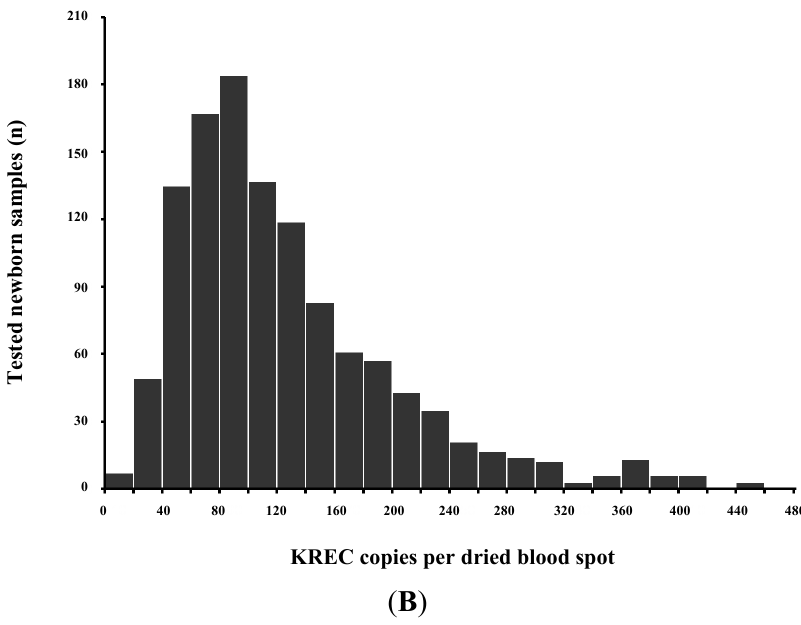
Figure 3. ( A ) Normal distribution TREC copies from dried blood spot analysis in n = 1200 healthy newborns, as well as 10 samples with patients with low TREC copy numbers during initial screening; ( B ) Normal distribution kappa-deleting recombination excision circles (KREC) copies from dried blood spot analysis in n = 1200 healthy newborns, as well as 10 samples with patients with low KREC copy numbers during initial